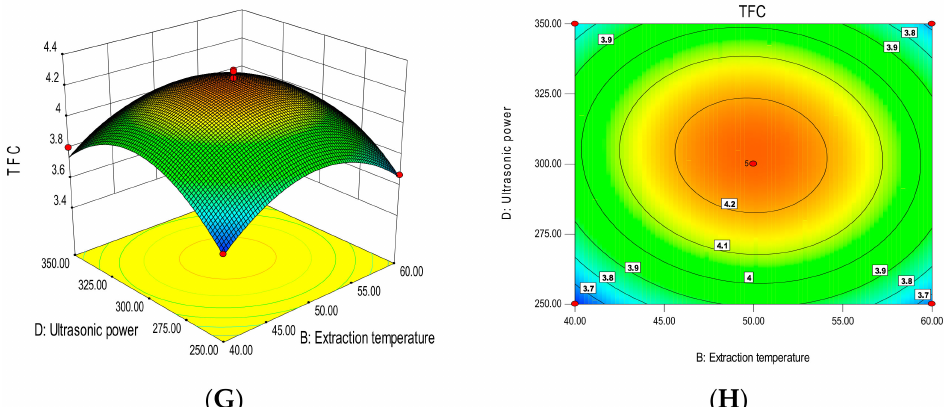
Figure 3. Three-dimensional response surface plots and corresponding contour plots. Influence of the extraction temperature and extraction time ( A , B ) and the extraction temperature and ultrasonic power ( C , D ) on TPC; the water content and ultrasonic power ( E , F ) and the extraction temperature and ultrasonic power ( G , H ) on